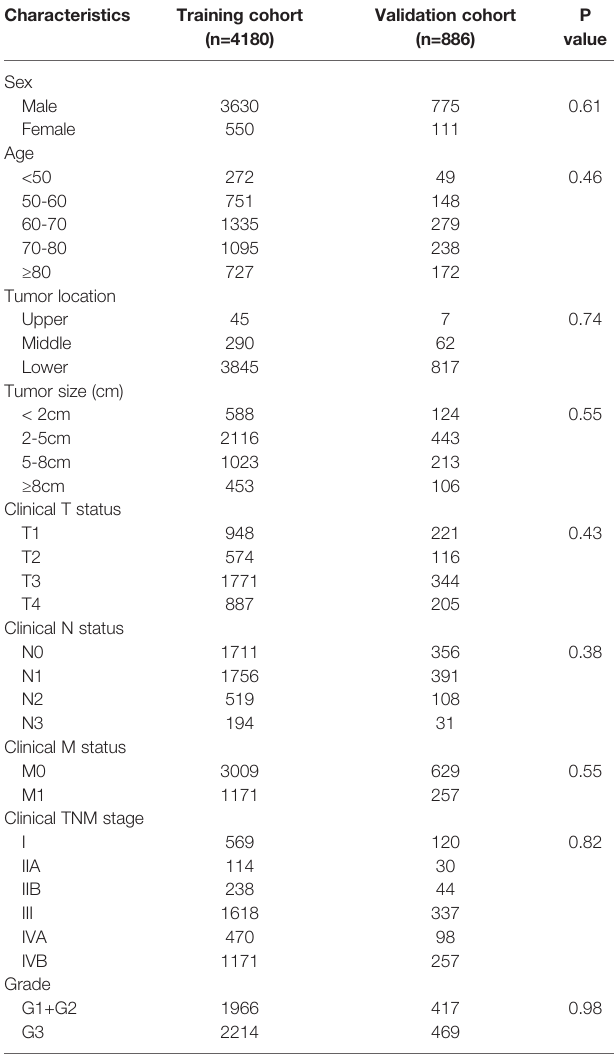
TABLE 1 | Demographic characteristics of the training and validation